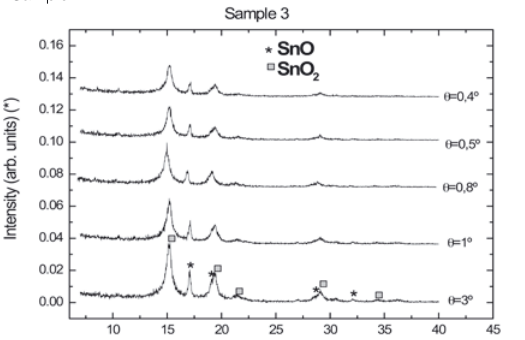
Figure 8. XPS spectra of amalgam layer (~5 nm) of samples: (a) Samples 1, 2, and 3, (b) Sample 4.